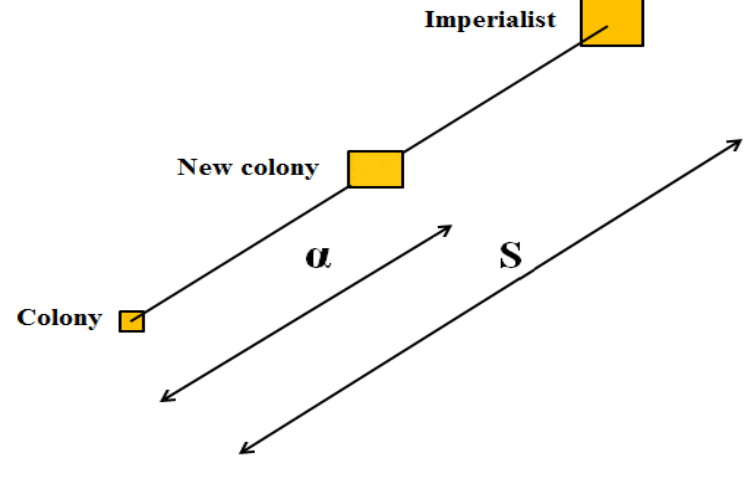
Figure 6. Initial population of ICA.